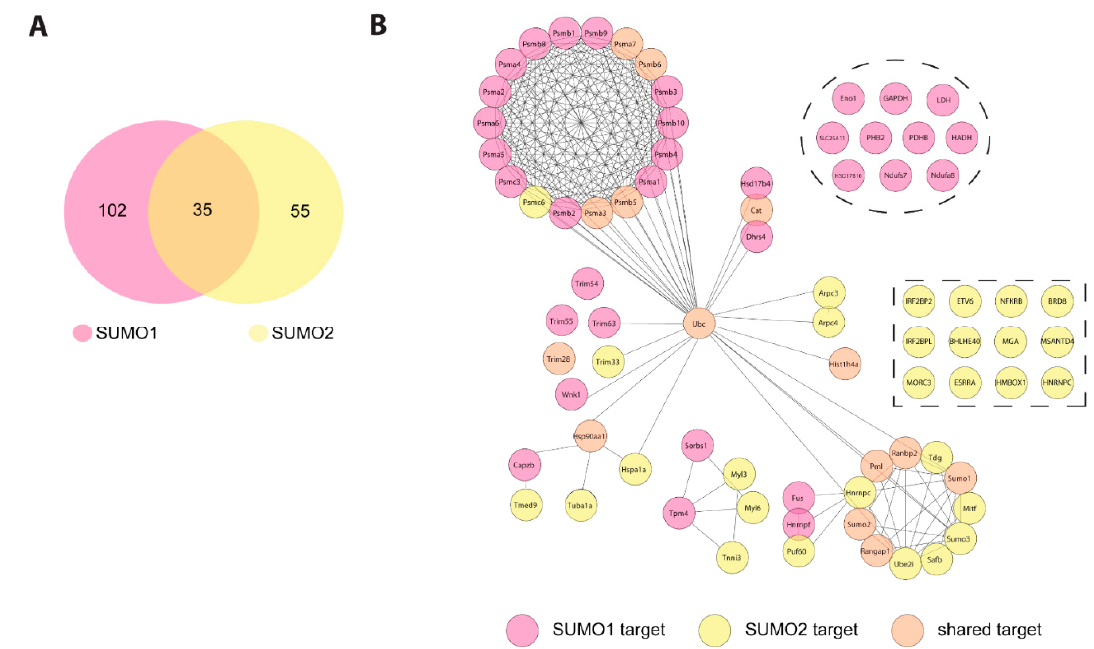
Figure 3. SUMO1 and SUMO2 target protein network in cardiac I/R injury. ( A ) Venn diagram depicting the number of exclusive and overlapping SUMO1 and SUMO2/3 target proteins after imputation of missing values in cardiac I/R injury. ( B ) STRING network of SUMO1 and SUMO2/3 target proteins in cardiac I/R injury. Identified target proteins of both SUMO1 and SUMO2/3 IP were analyzed regarding functional network clustering using STRING database. For STRING analysis, parameters were set at highest confidence level and used MCL clustering with inflation of 3. Proteins are coloured according to their identification in either SUMO1 ‐ or SUMO2/3 ‐ or both IP’s.